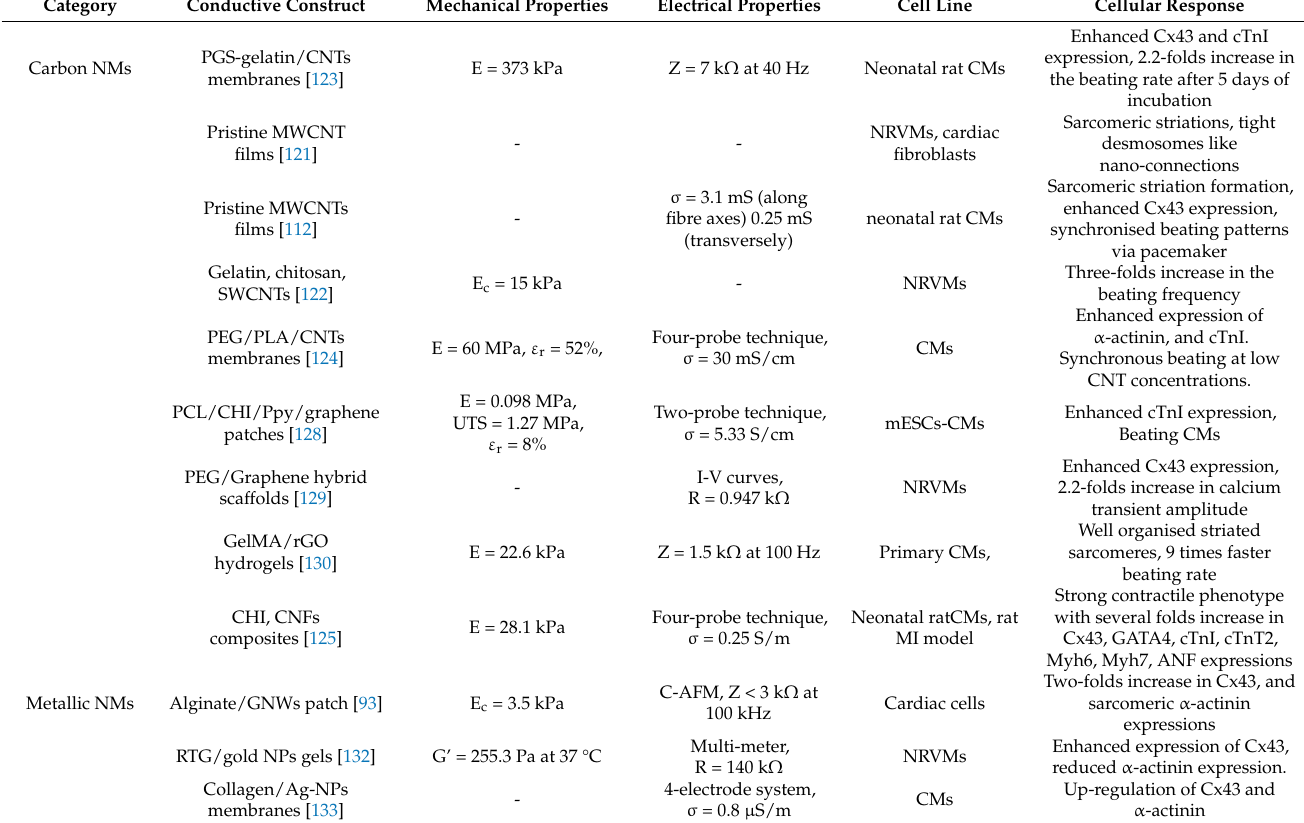
Table 5. Effect of conductive nano-construct on intercellular coupling and